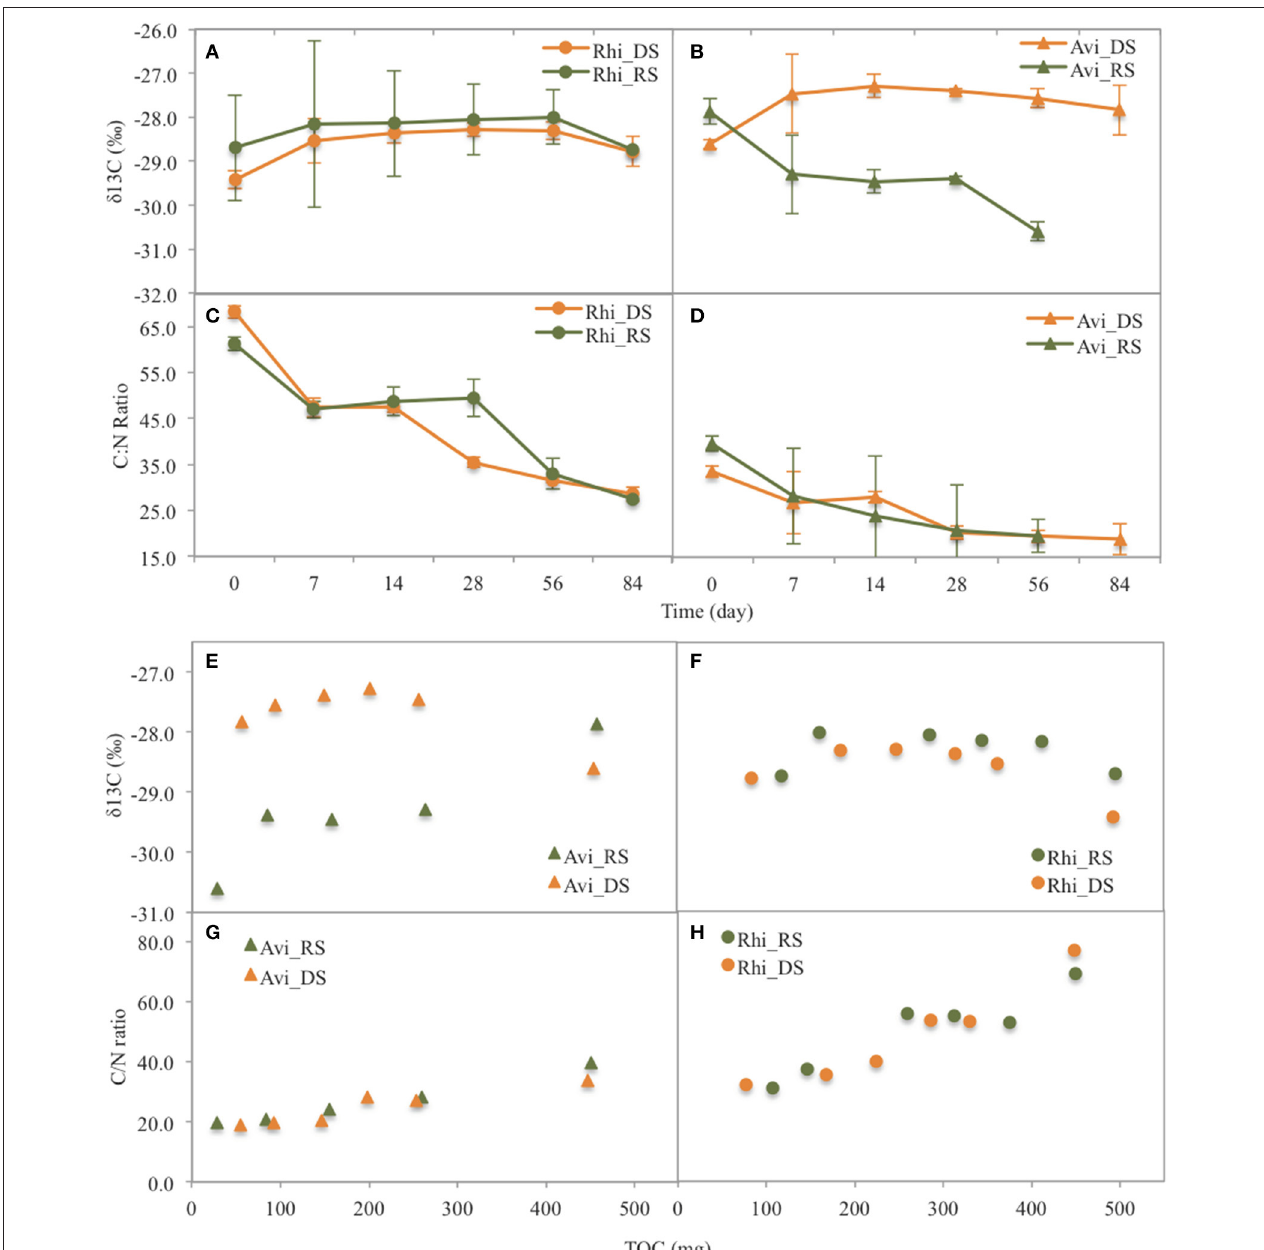
FIGURE 5 | Changes (with time and with TOC) of δ 13 C values and C/N ratios of the leaf litter of the two species Rhizophora (Rhi) and Avicennia (Avi) during leaf litter decomposition at the two seasons (DS: dry season, RS: rainy season). (A) δ 13 C with time for Rhizophora , (B) δ 13 C with time for Avicennia , (C) C/N with time for Rhizophora , (D) C/N with time for Avicennia , (E) δ 13 C with TOC for Avicennia , (F) δ 13 C with TOC for Rhizophora , (G) C/N with TOC for Avicennia , (H) C/N with TOC for Rhizophora